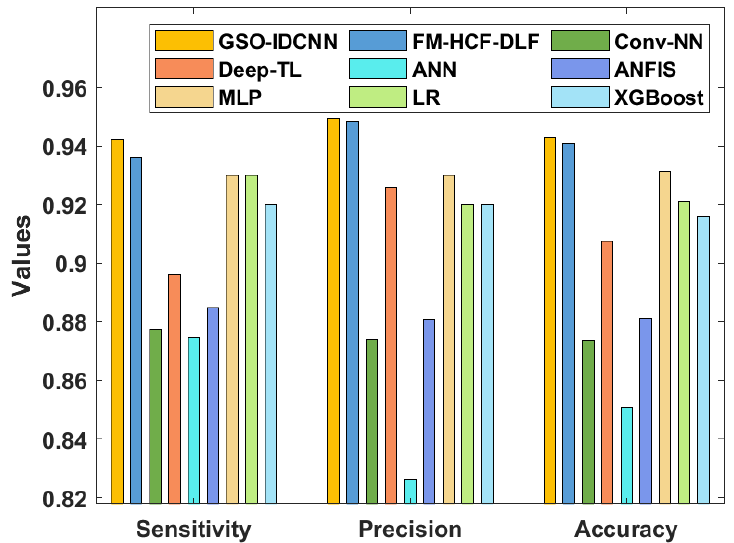
Figure 8. Comparative analysis of the GSO-IDCNN technique with different measures.